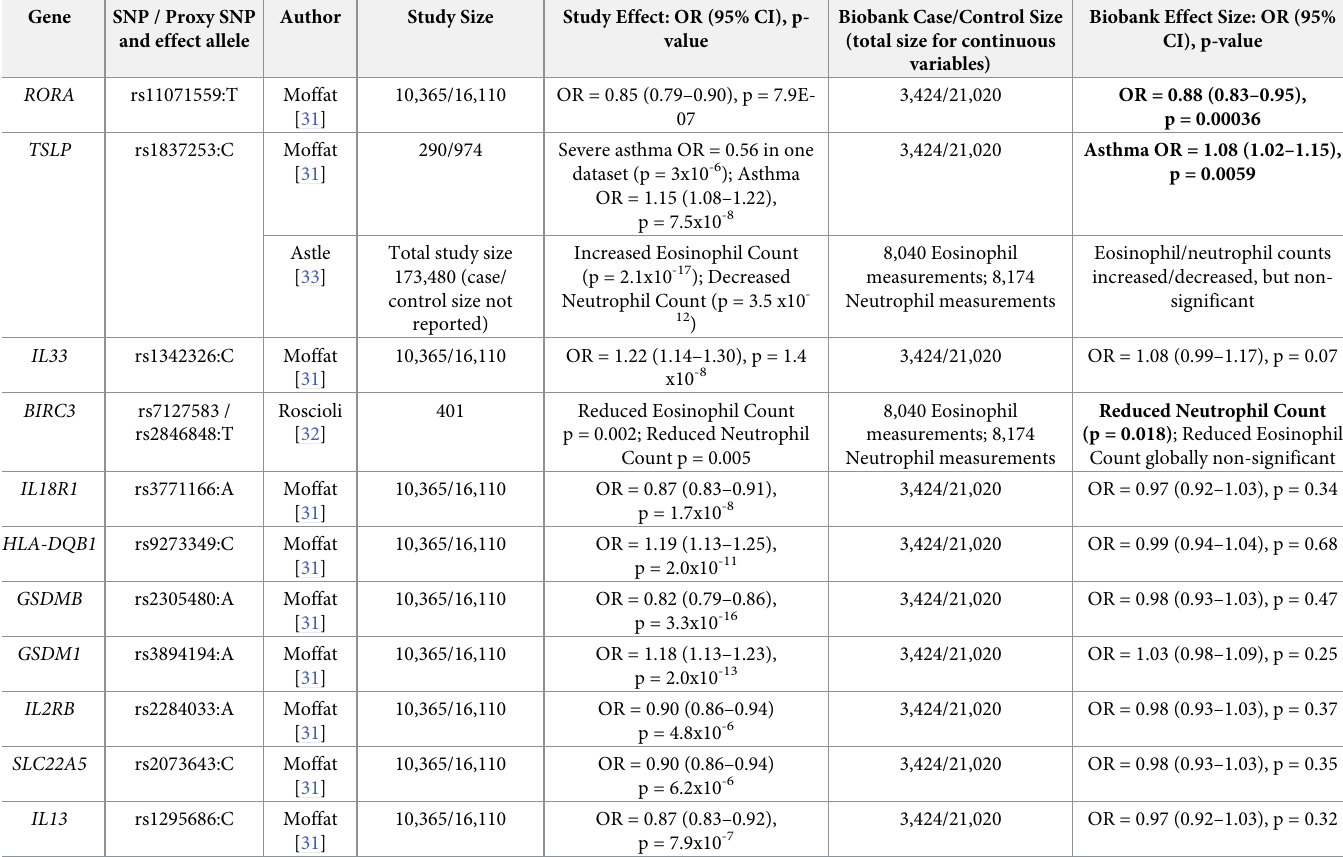
Table 4. Association between genetic variants and asthma (J45-J46) diagnosis/laboratory measurements in the Estonian